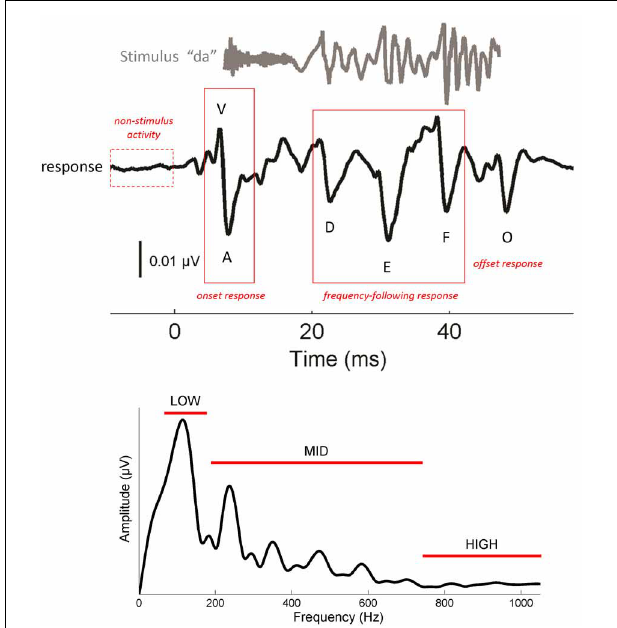
FIGURE 1 | Characteristics of the cABR (Top). The complex stimulus [da] (gray) elicits a stereotyped cABR (black) with 6 characteristic peaks (V, A, D, E, F, O). V and A represent the onset response. D, E, and F occur within the frequency-following response (FFR), and O reflects the offset response. The stimulus waveform is shifted by ∼ 6.8ms to maximize the visual coherence between the two signals in this figure. To obtain a measure of non-stimulus activity, the root-mean-square amplitude of the response to the 15ms interval preceding the stimulus was taken. (Bottom) Frequency domain representation of the FFR (19.5–44.2ms). Spectral amplitudes were calculated over three frequency ranges: low (75–175), mid (175–750) and high (750–1050Hz). Waveforms represent the grand averages of the young adult group (21–40 year